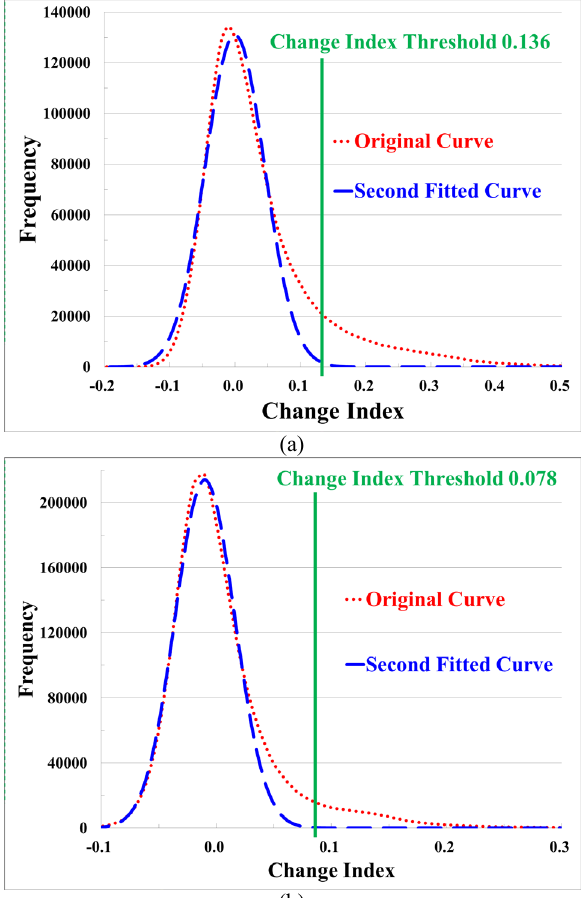
Figure 6. Curves of change index distribution over PS points in (a) vanishment and (b) emergence scenarios in